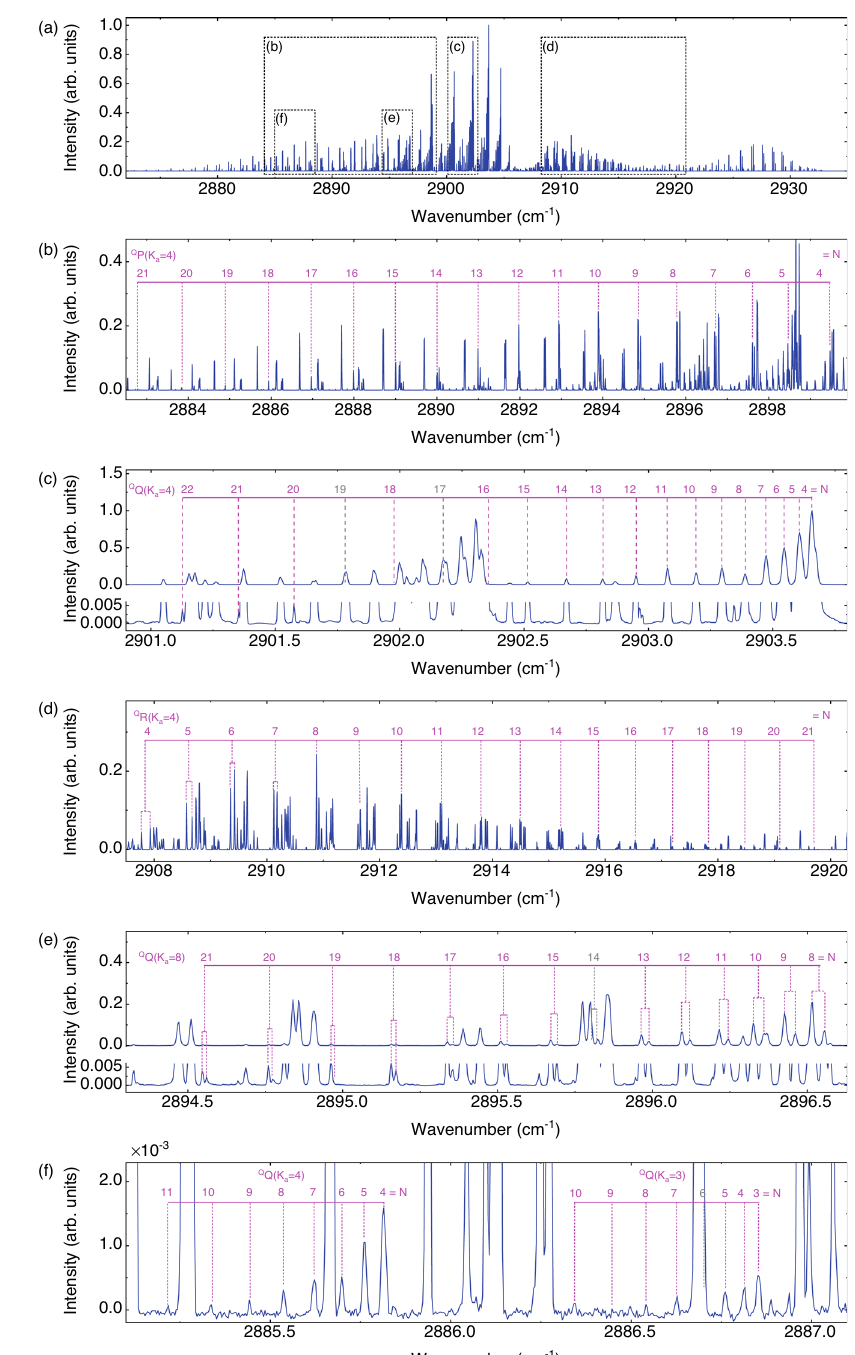
Fig. 3 | Measured intensity spectrum of DC-OAS. a Experimental DC-OAS inten- sityspectrumofNO 2 obtainedfromacontinuous1000srecordingandsampledat exactlythecomb-linespacingof108MHzfrom2870to2940cm − 1 .Thespectrumis normalized by a background spectrum, removing the in fl uence of spectral shape on the relative intensity of spectral lines. b – f Magni fi ed views surrounded by